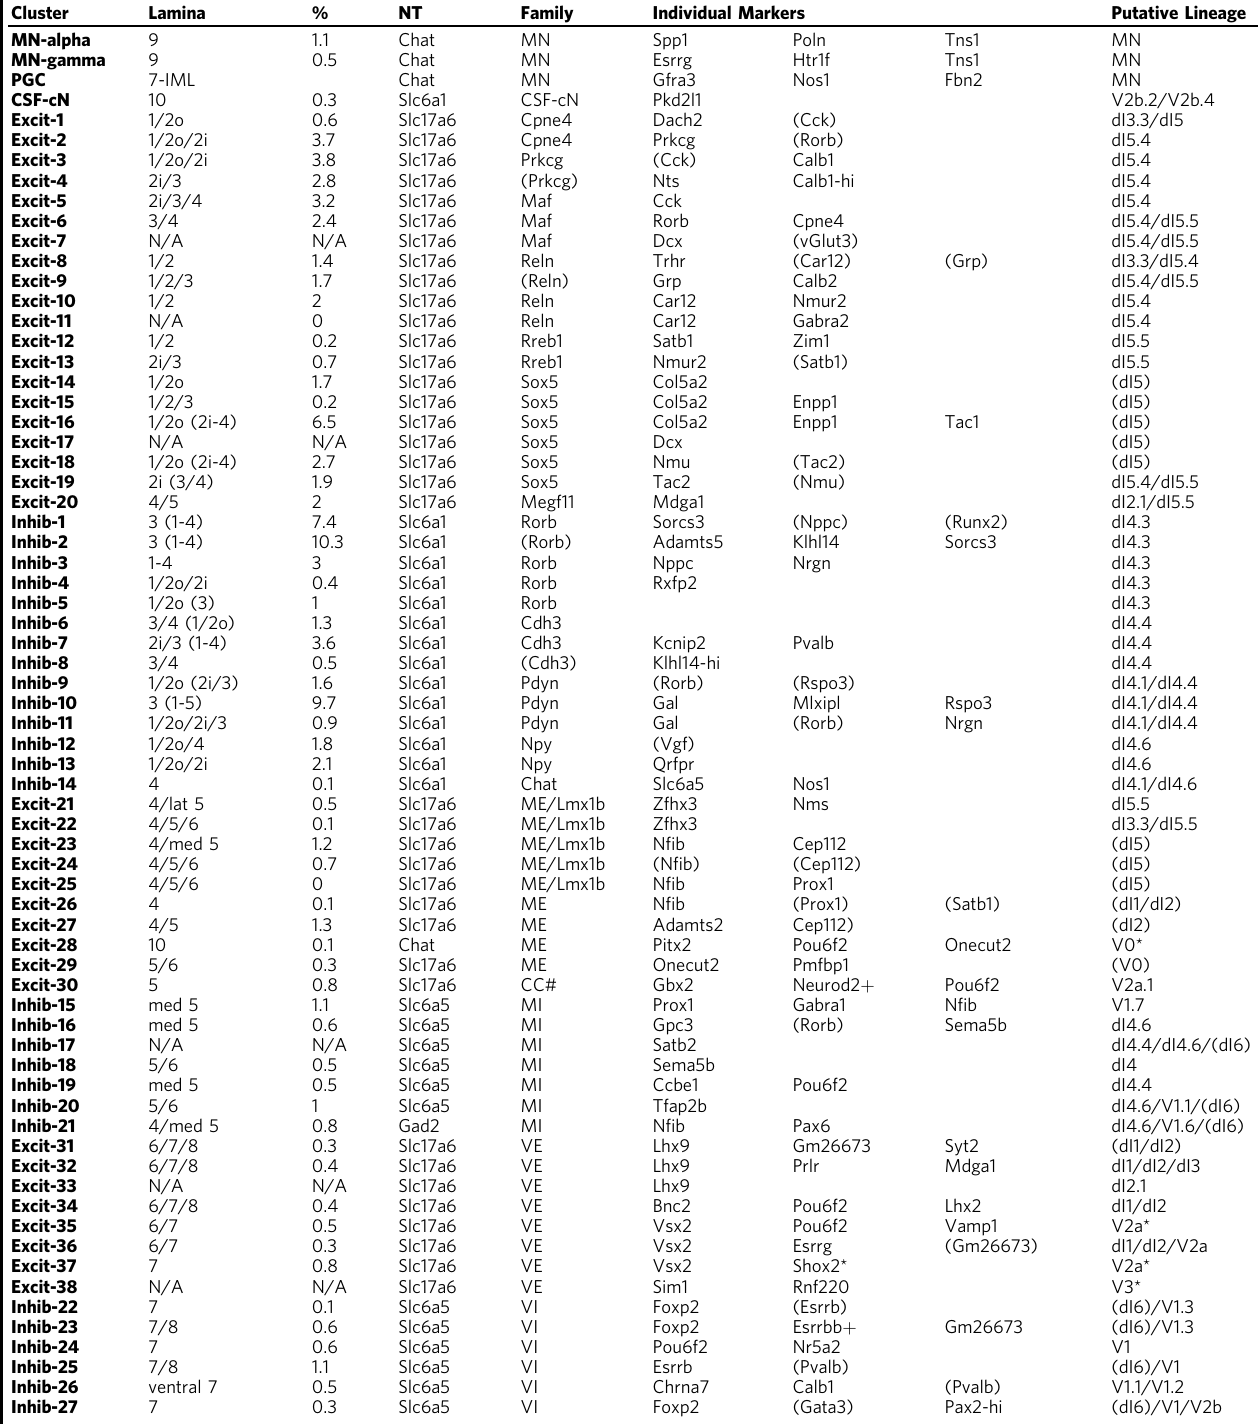
Table 1 Cell-type census of 69 populations of spinal cord neurons.